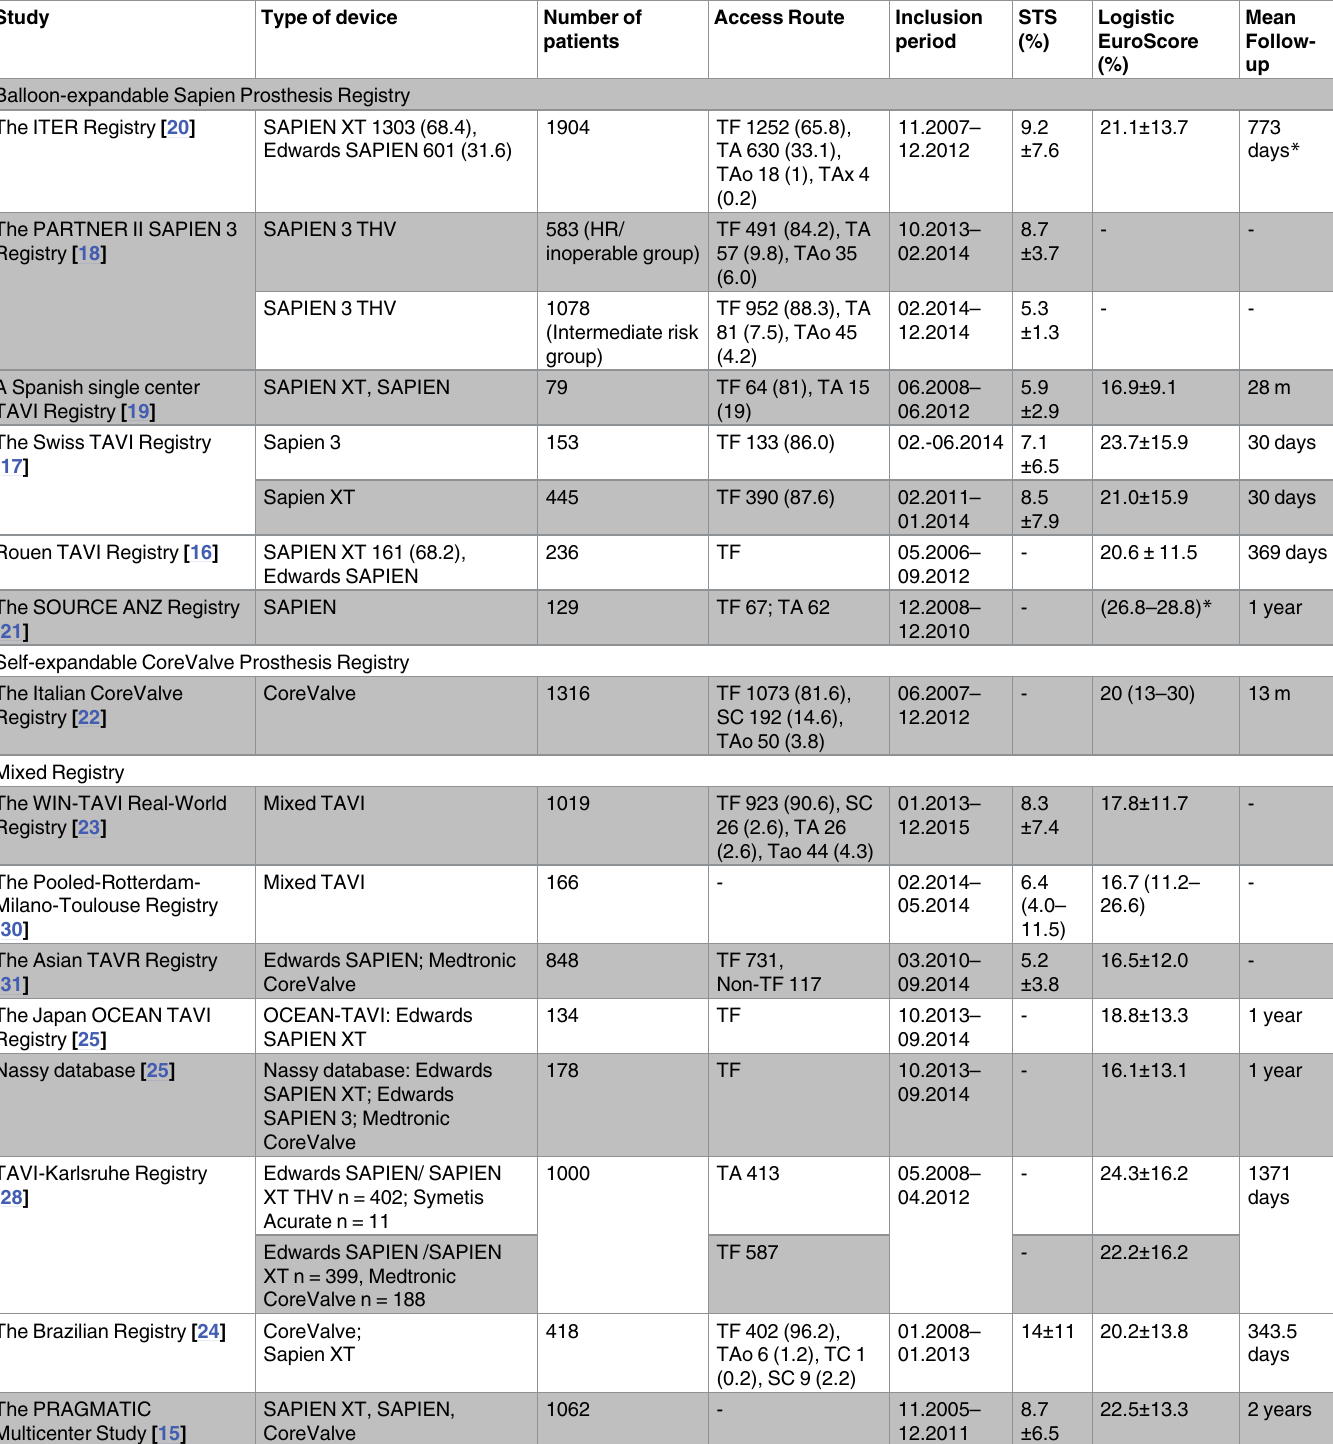
Table 2. Study characteristics with patient characteristics and procedure